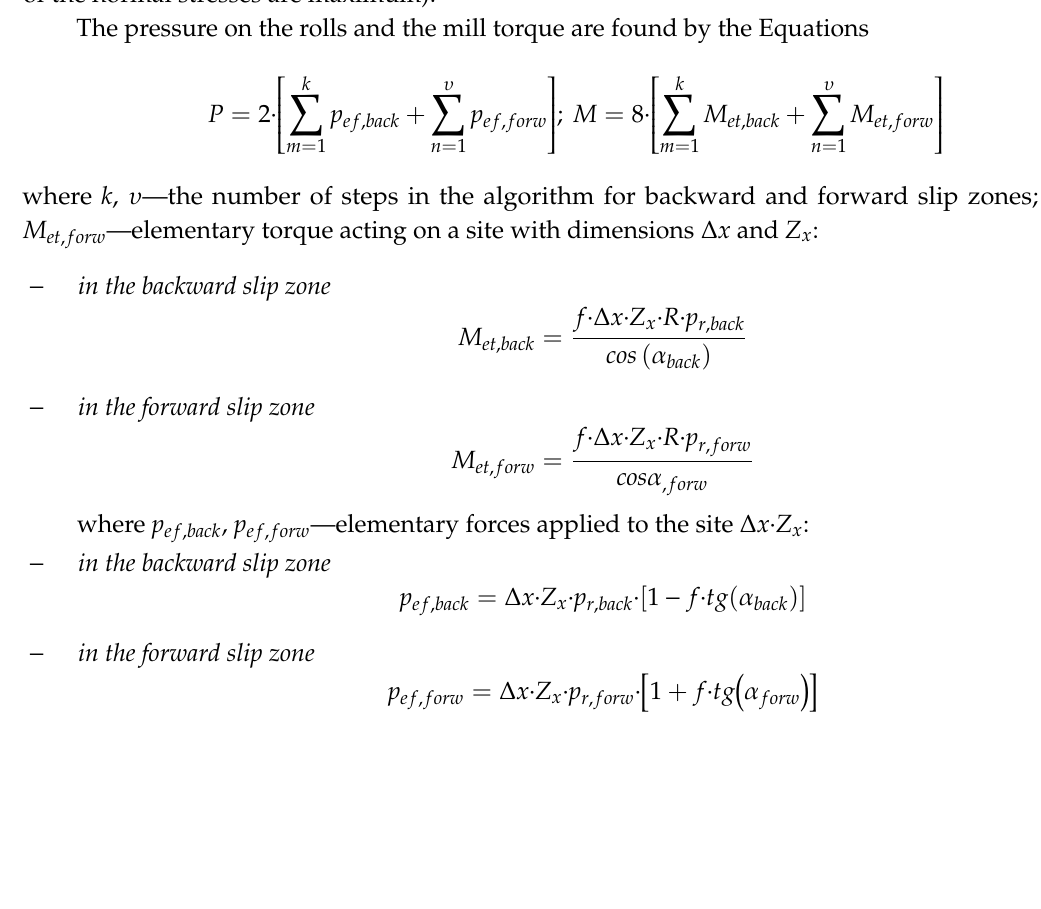
Figure 4. Explanations for the derivation of equations for